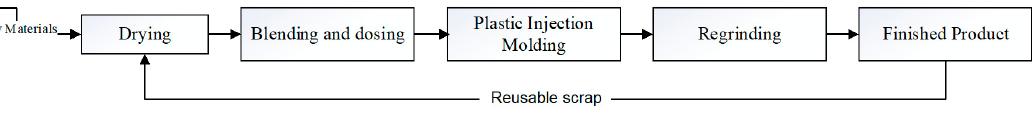
Figure 1. Stages of an injection molding